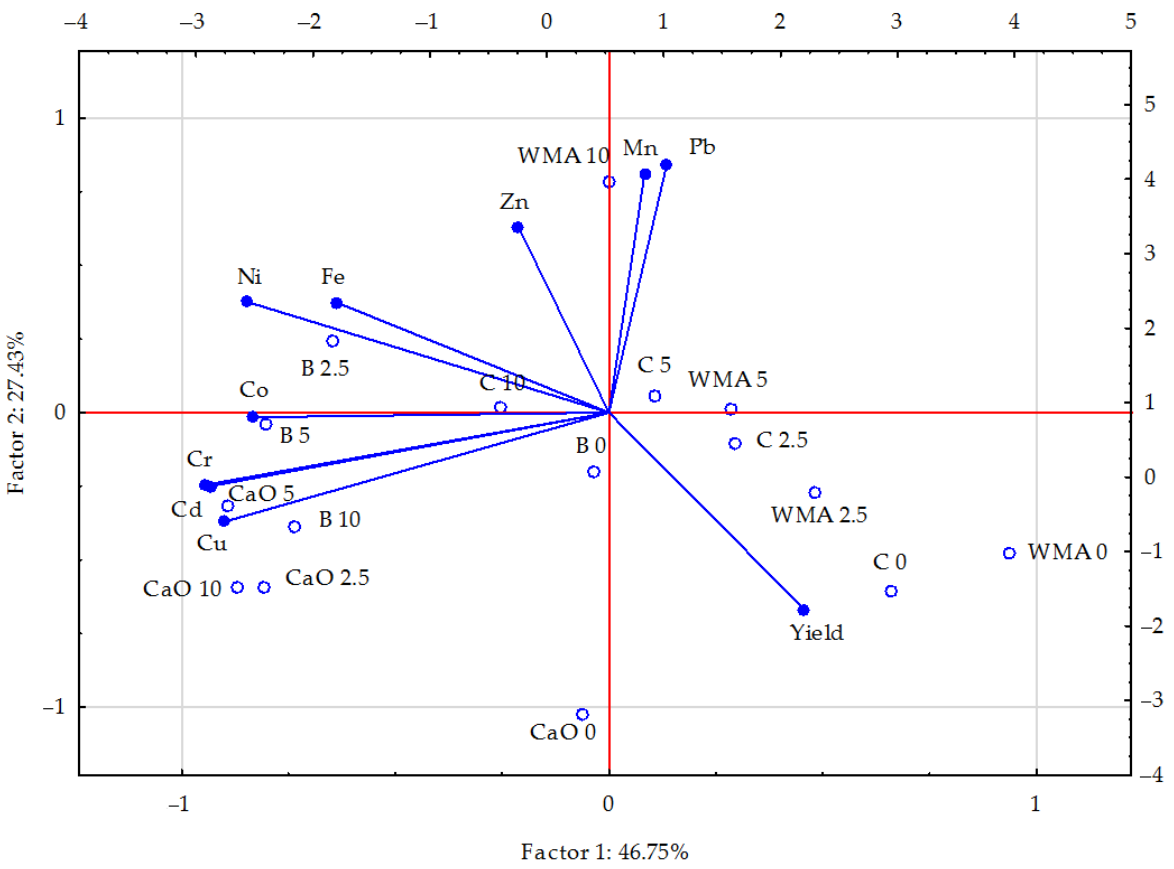
Figure 1. Content of heavy metals in the aerial parts of maize ( Zea mays L.) illustrated with the PCA method. Key: vectors represent analysed variable (content of Cd, Pb, Cr, Ni, Zn, Cu, Mn, Fe, and Co; left, Y, and bottom, X axis), points show the samples with elements (WMA—without material amendments, C—compost, B—bentonite, and CaO—calcium oxide; 0—0 cm 3 (control), 2.5—2.5 cm 3 , 5—5 cm 3 , and 10—10 cm 3 petrol per kg of soil; right, Y, and top, X axis) .